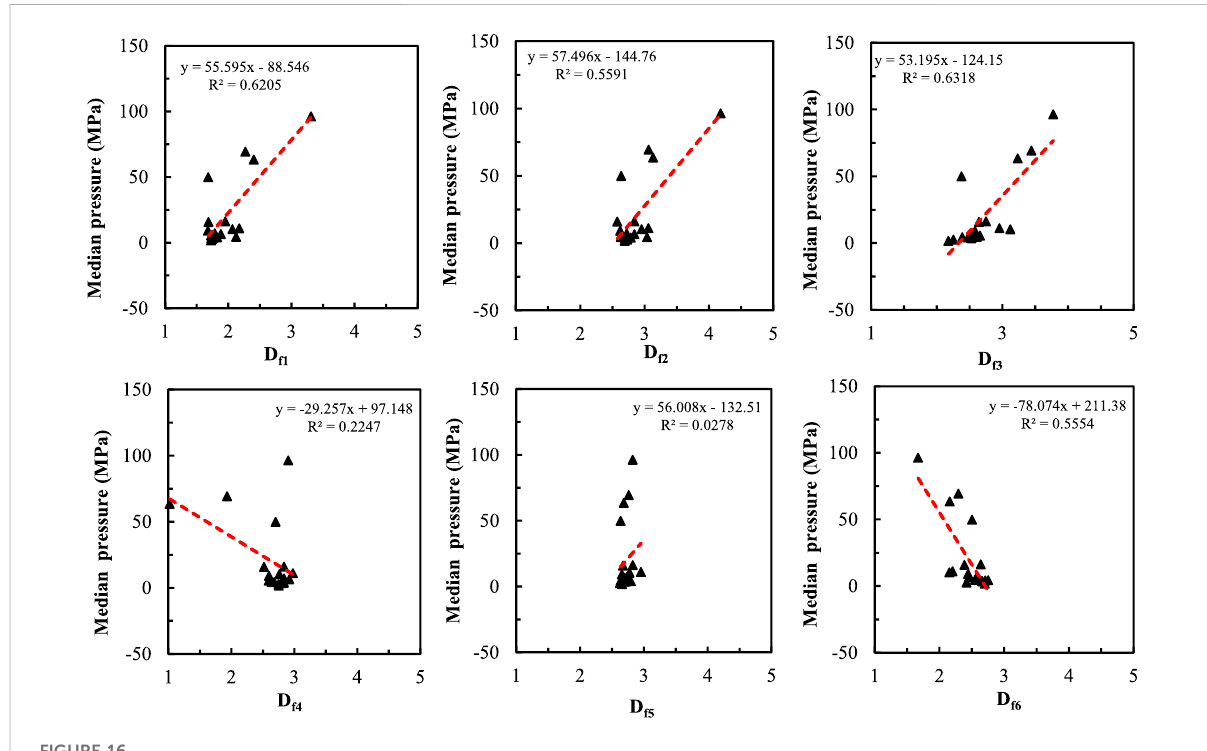
FIGURE 16 Relationship between median pressure and fractal dimension calculated by